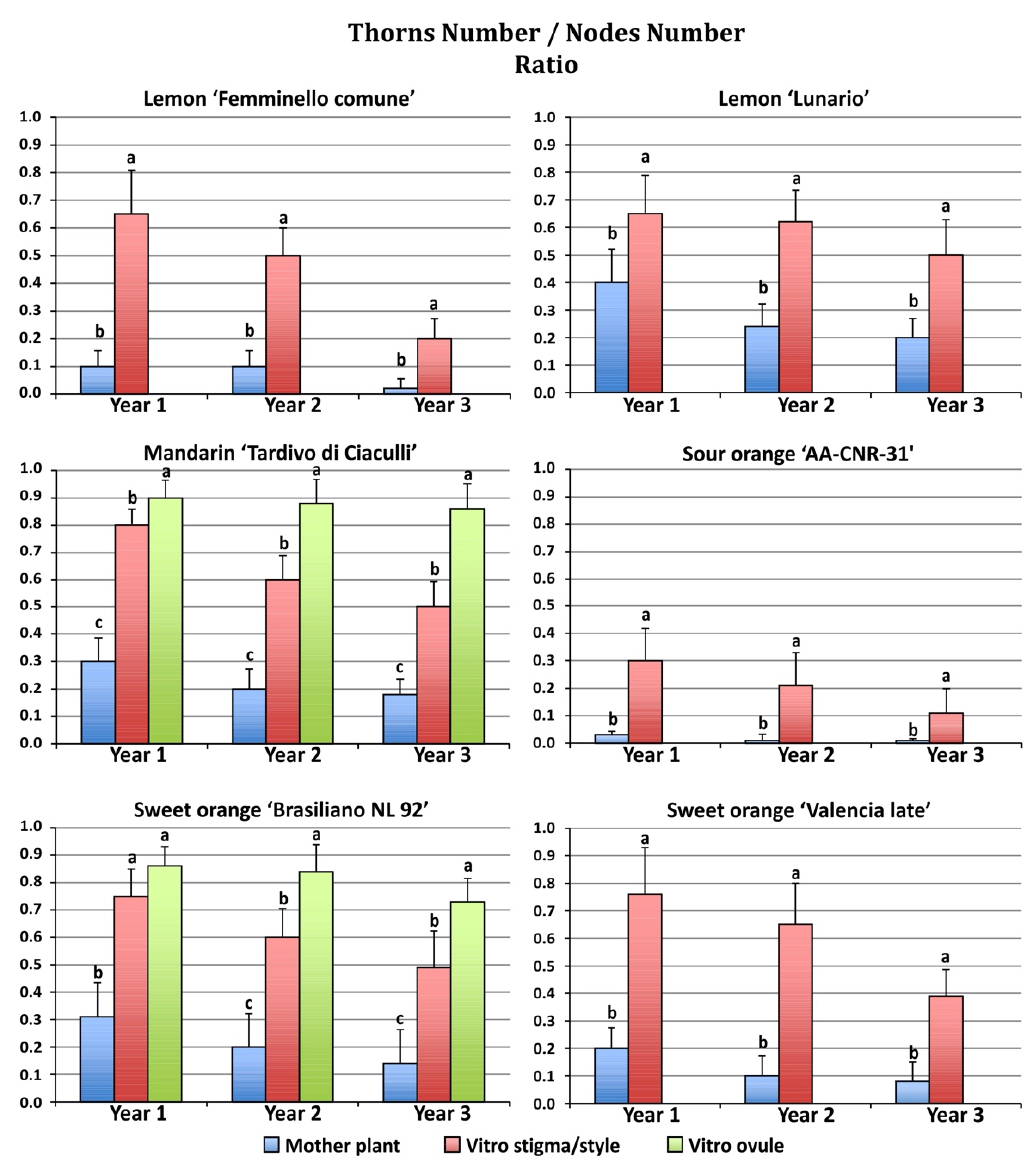
Figure 4. Average thorn/node ratio in plants regenerated from different explants growing in the field during the first three years after grafting. Different letters on bars indicate significantly different values at a particular genotype according to the t -test for ‘Femminello comune’, ‘Lunario’ lemon, ‘AA CNR 31’ sour orange and ‘Valencia late’ sweet orange and according to Tukey’s multiple comparison test for ‘Tardivo di Ciaculli’ mandarin and ‘Brasilian NL92’ sweet orange. Tests were performed at p < 0.05 significance level within each year. Bars indicate standard error.